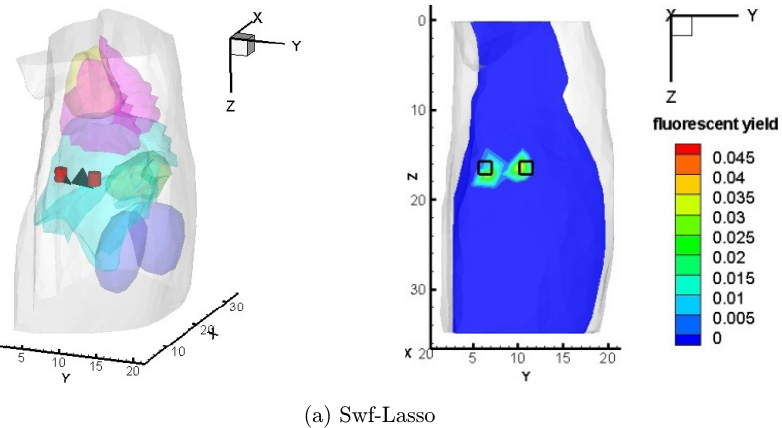
Fig. 4. Reconstruction results for double targets, two red cylinders represent the actual sources and the black region means the position of